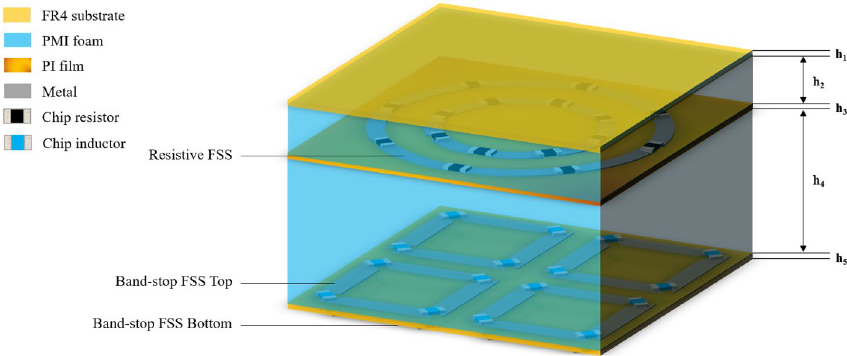
Figure 1. Geometrical configuration of the proposed HADTR.